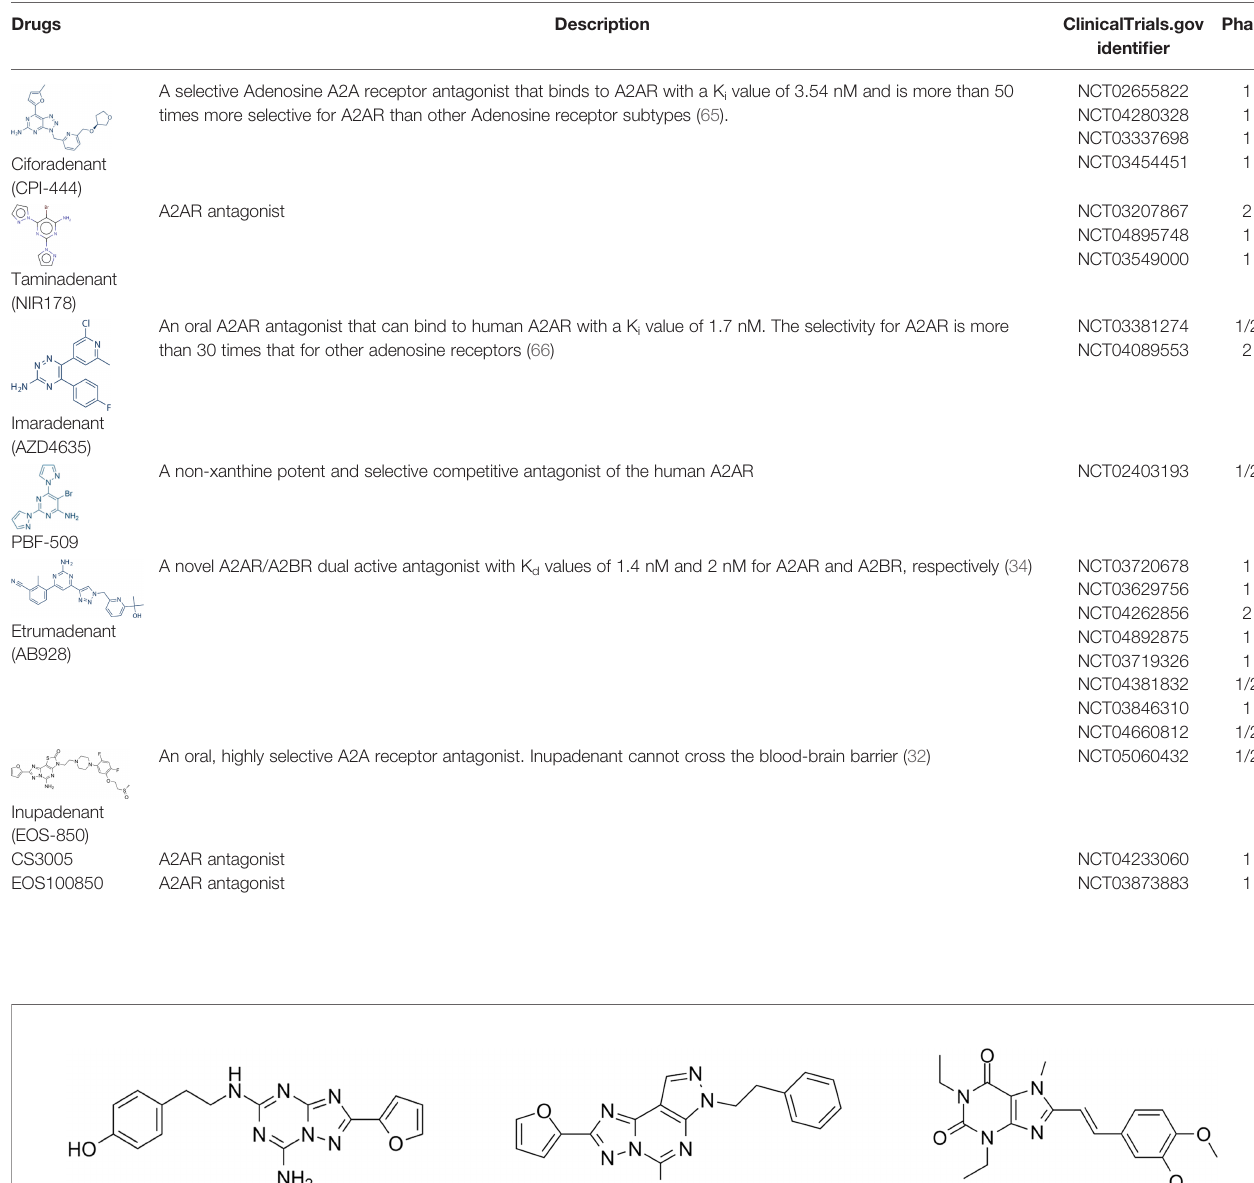
TABLE 1 | A2AR selective antagonists in clinical trials for cancer Immunotherapy.